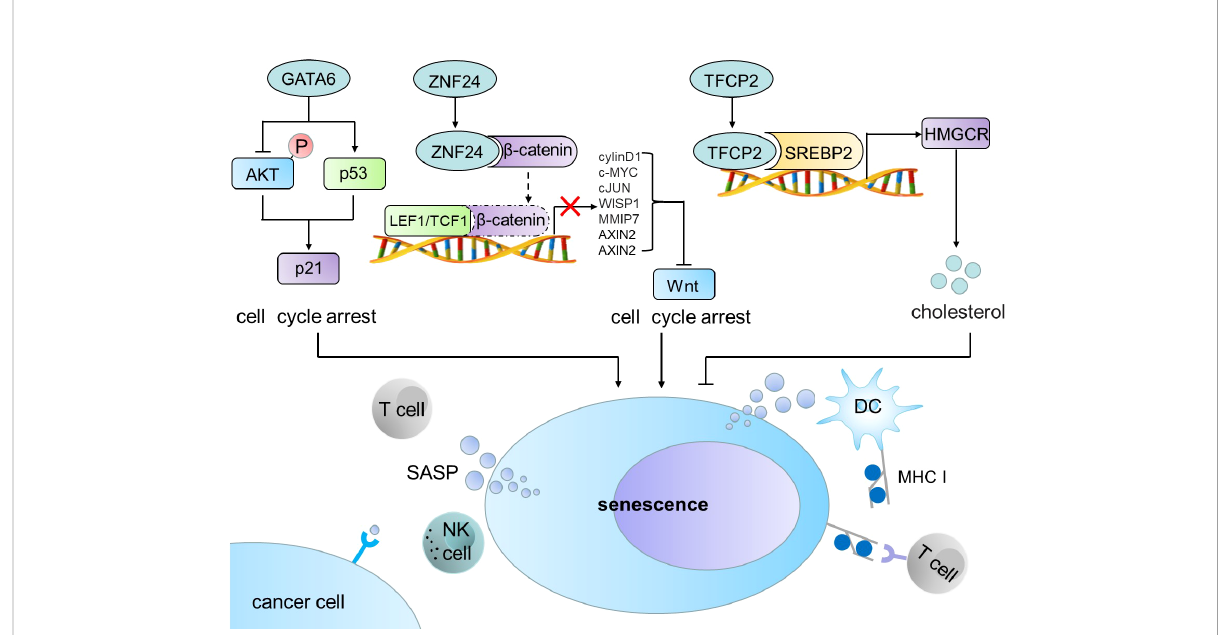
FIGURE 1 GATA6, ZNF24 and TFCP2 induce cell senescence and trigger anti-tumor immune response. GATA6 induces cell senescence in cancer cells by up-regulating p21 and p53 and inhibiting AKT. ZNF24 inhibits WNT signaling pathway by preventing b -catenin to form a complex with TCF1/ LEF1 and ultimately induces tumor cell senescence. TFCP2 interacts with SREBP2 to synergistically activate the expression of HMGCR and inhibit the senescence of tumor cells. Senescent tumor cells produce SASP, which can recruit and activate immune cells in TME to induce anti-tumor immunity. SREBP2, sterol regulatory element binding transcription factor 2; SASP, senescence-associated secretory phenotype; DC, dendritic cell; MHC I, major histocompatibility complex